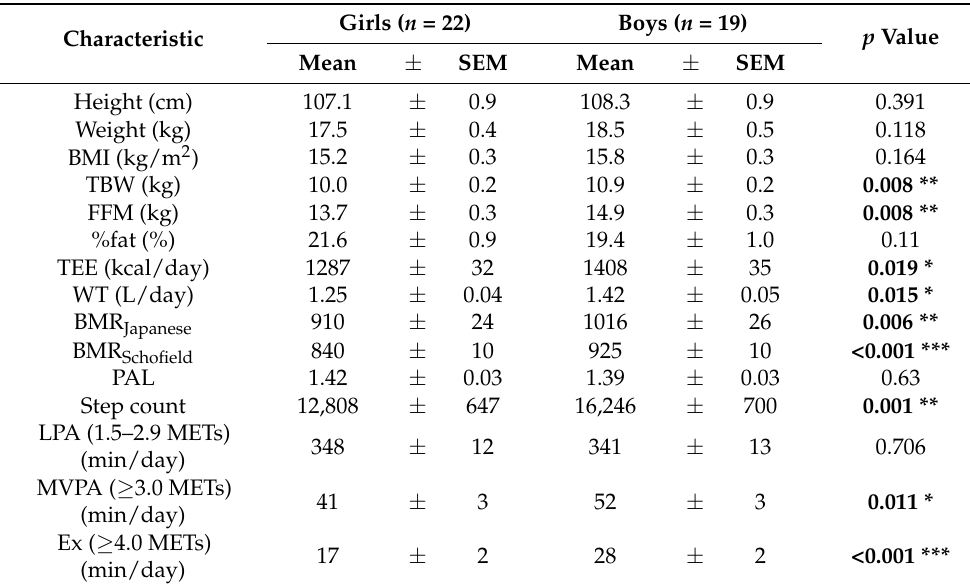
Table 2. Comparison between girls and boys using ANCOVA adjusted for age. Characteristic